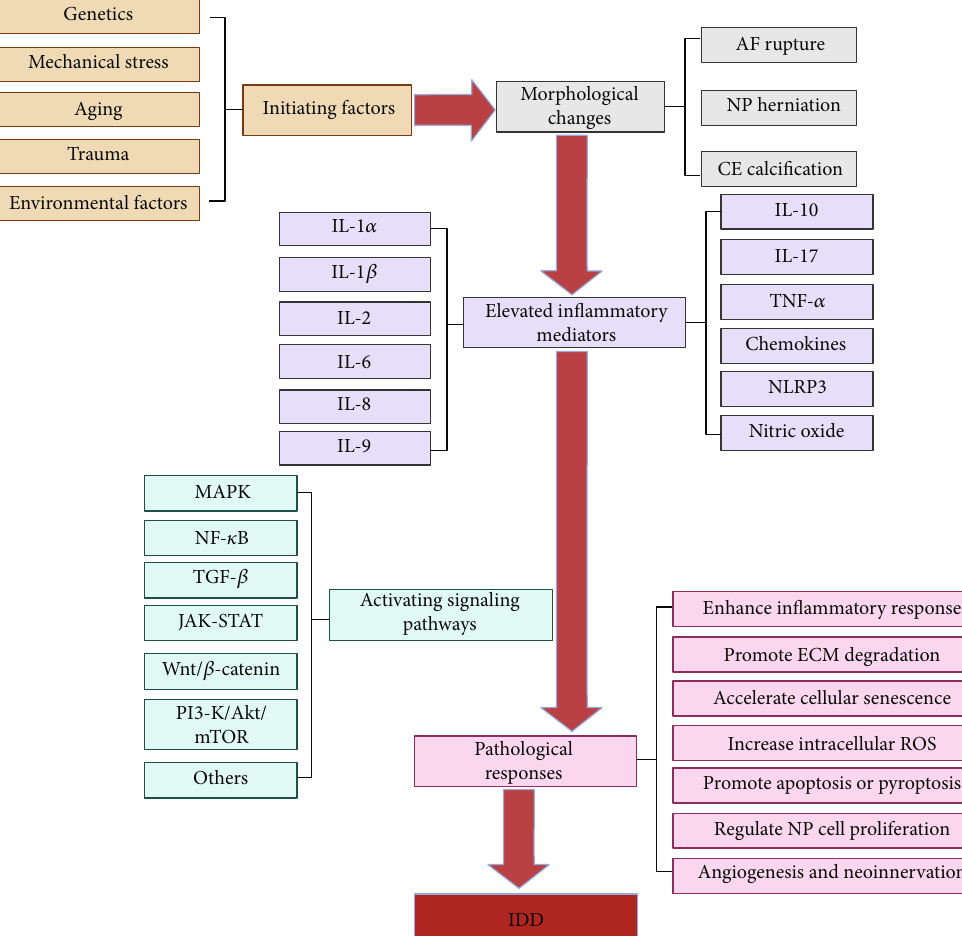
Figure 1: Diagram of IDD upstream and downstream regulation